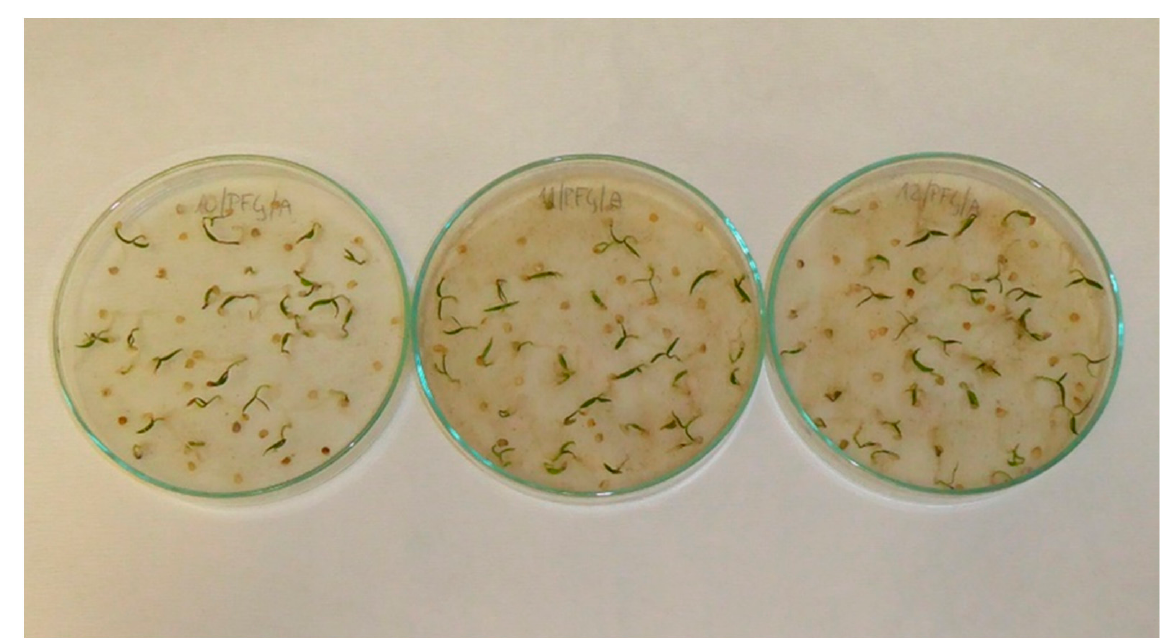
Figure A1. Pepper ( Capsicum anuum L.) seedlings; treatments with aqueous extracts of chia ( Salvia hispanica L.) in 2.5% concentration ( left ), 5% concentration ( middle ) and 10% concentration ( right ).